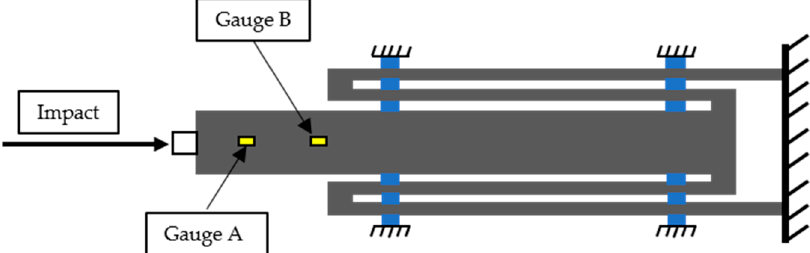
Figure 8. Serpentine transmitted bar loaded in compression, with two strain gauge stations (yellow), the specimen (white), and bushings (blue) (the figure is reproduced from [69], with permission from the Elsevier, 2015).